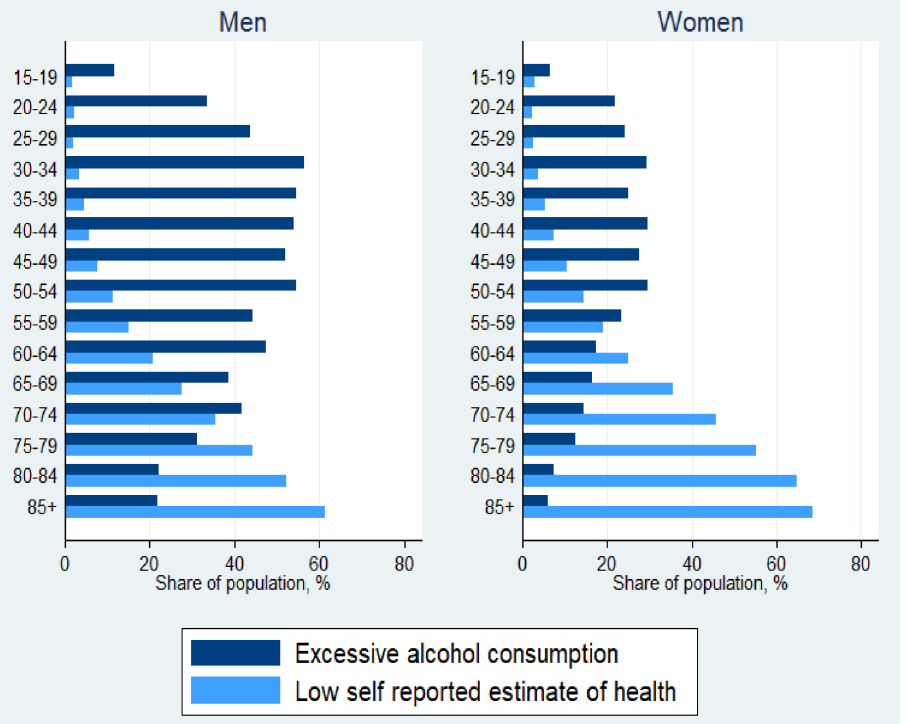
Figure 3. Prevalence of excessive alcohol consumption and low health estimates depending on age, males and females, 2018. Source : author’s calculations based on the RLMS and Russian Fertility and Mortality Database